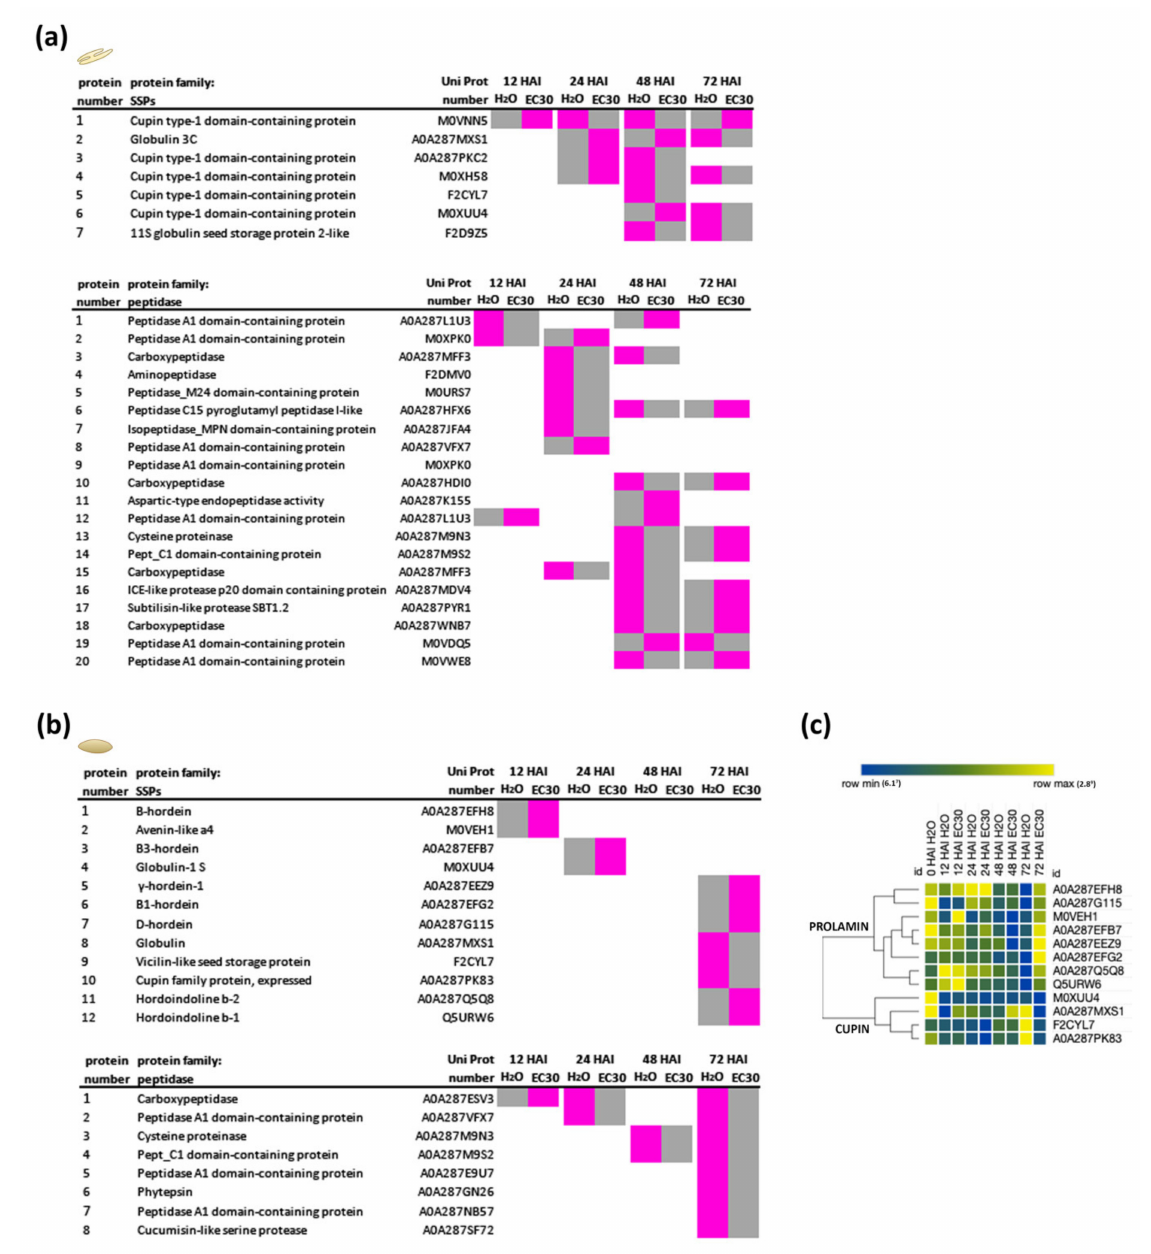
Figure 5. The classification of significantly differently expressed SSPs in the embryo and in the endosperm when germinated in H 2 O and EC30. ( a ) Seven significantly differently expressed SSPs in the embryo. Depending on the point in time, the protein was more (magenta) or less (grey) abundant. All of these proteins belonged to the CUPIN family. A total of 20 peptidases within the embryo were significantly more abundant, mostly at 48 and 72 HAI. ( b ) In the endosperm, the abundance of 12 SSPs was significantly altered. Eight peptidases in the endosperm were most abundant when germinated in H 2 O from 24 HAI on. Magenta = high abundance, grey = low abundance. Statistical analyses: multiple-unpaired t-test. ( c ) HCA analysis of protein abundances (LFQ-intensities) of the SSPs from the PROLAMIN and CUPIN